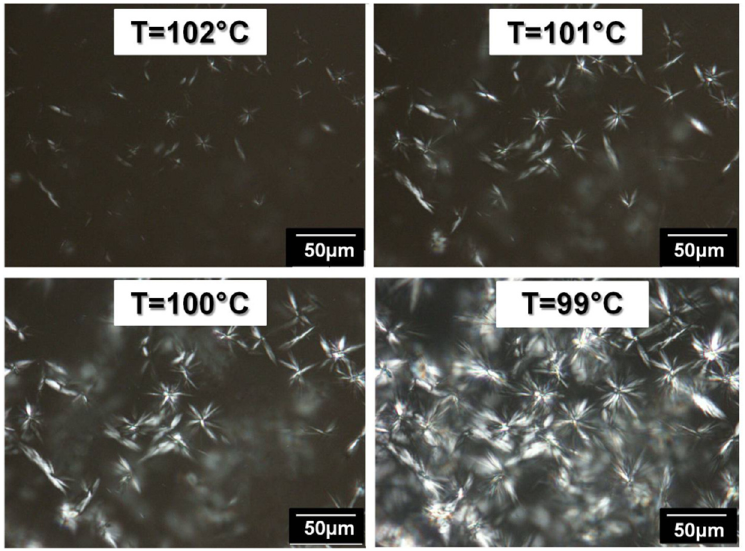
Figure 9. PE spherulites crystallization observed by optical microscopy with polarized light during a cooling ramp.